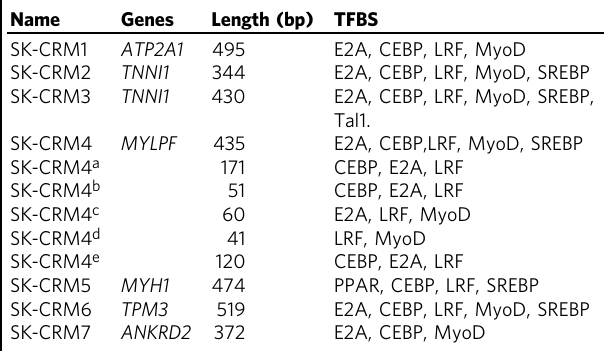
Table 1 Sequence and details of the Sk-CRMs